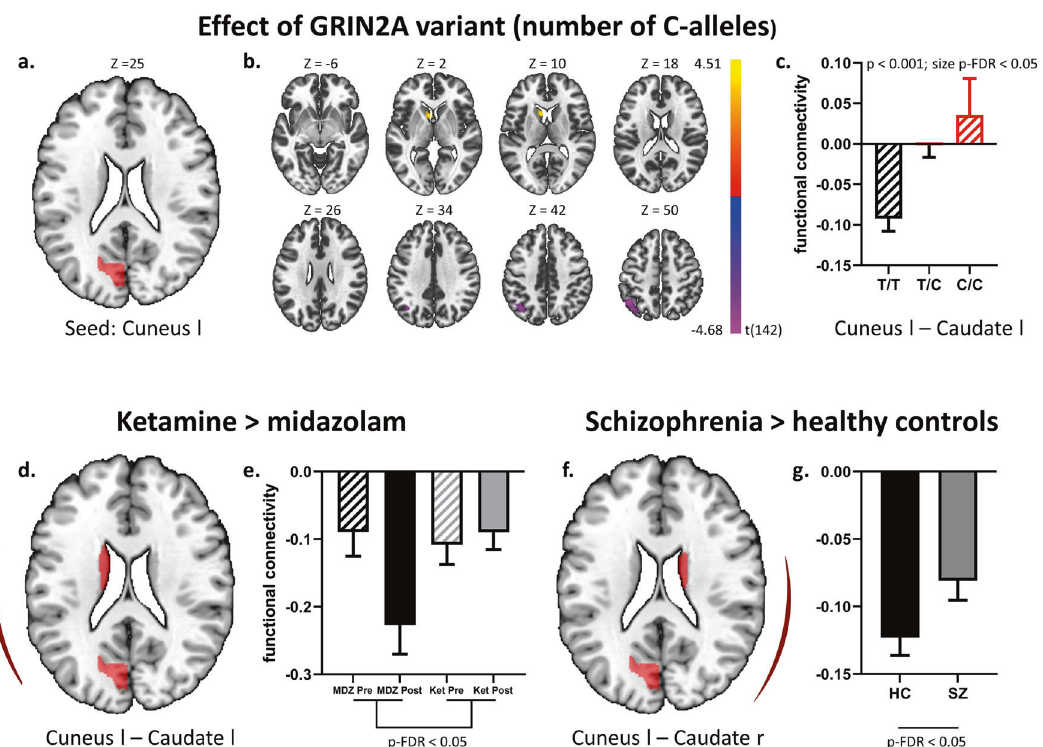
Fig. 3 Hyper-connectivity between the cuneus and caudate. The impact of the genetic variant (C-allele) on the functional connectivity pro fi le of the left cuneus was assessed using a seed-to-voxel-analysis ( a – c ). The location of the seed is demonstrated in a . Statistically signi fi cant clusters of hyper (left caudate)- or hypo-connectivity (left superior lateral occipital cortex) at a voxel-wise threshold of p < 0.001 and a cluster-size threshold of p-FDR < 0.05 are presented in b . Mean connectivity estimates (Fisher-z-transformed correlation coef fi cients) of the connectivity between the left cuneus and left caudate are depicted for each genotype using bar plots in c . The two connections of the cuneus which were affected by the genetic variant were subsequently assessed in the pharmaco-fMRI dataset (ketamine > midazolam, d , e ) as well as the combined schizophrenia/control dataset (schizophrenia > healthy controls, f , g ) applying ROI-to-ROI functional connectivity analyses. For the ketamine > midazolam contrast, we observed signi fi cant hyper-connectivity between the left cuneus and the left caudate, too, which was mainly explained by more negative connectivity estimates emerging after midazolam application. For the schizophrenia > healthy controls contrast we did not observe any signi fi cant group differences for the two connections and therefore also assessed the connections of the left cuneus with the corresponding contralateral (i.e. right) regions which indeed revealed a signi fi cant hyper-connectivity with the right caudate. Error bars represent the standard error of the mean. l left; r